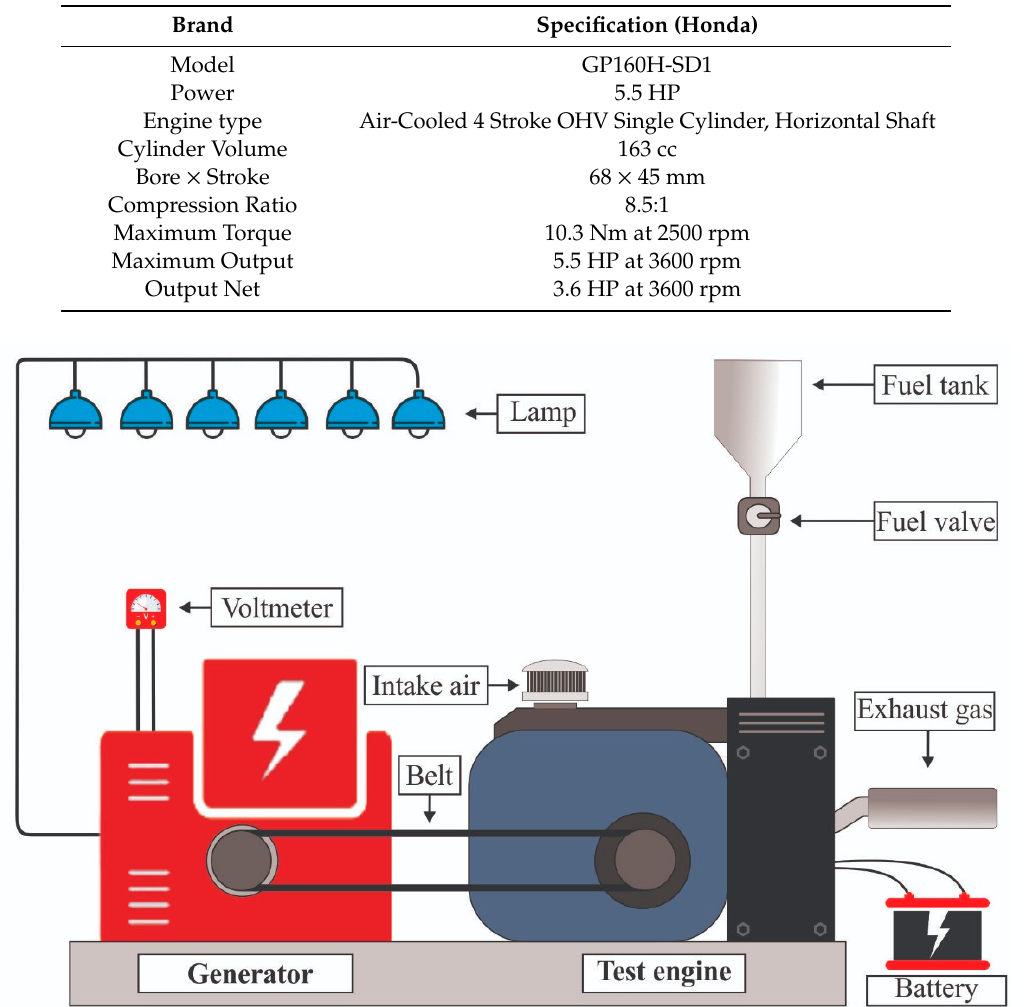
Table 2. The specification of the engine.